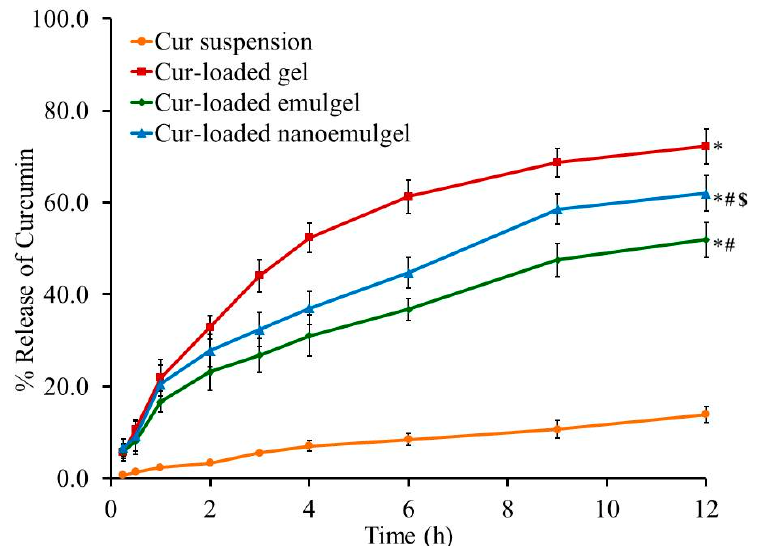
Figure 4. In vitro release study of Cur from different Cur-loaded formulations in phosphate buffer pH 7.4 at 37 °C. Results are expressed as the mean ± SD of three experiments. * p < 0.05 compared to Cur suspension. # p < 0.05 compared to Cur-loaded gel. $ p < 0.05 compared to Cur-loaded emulgel.